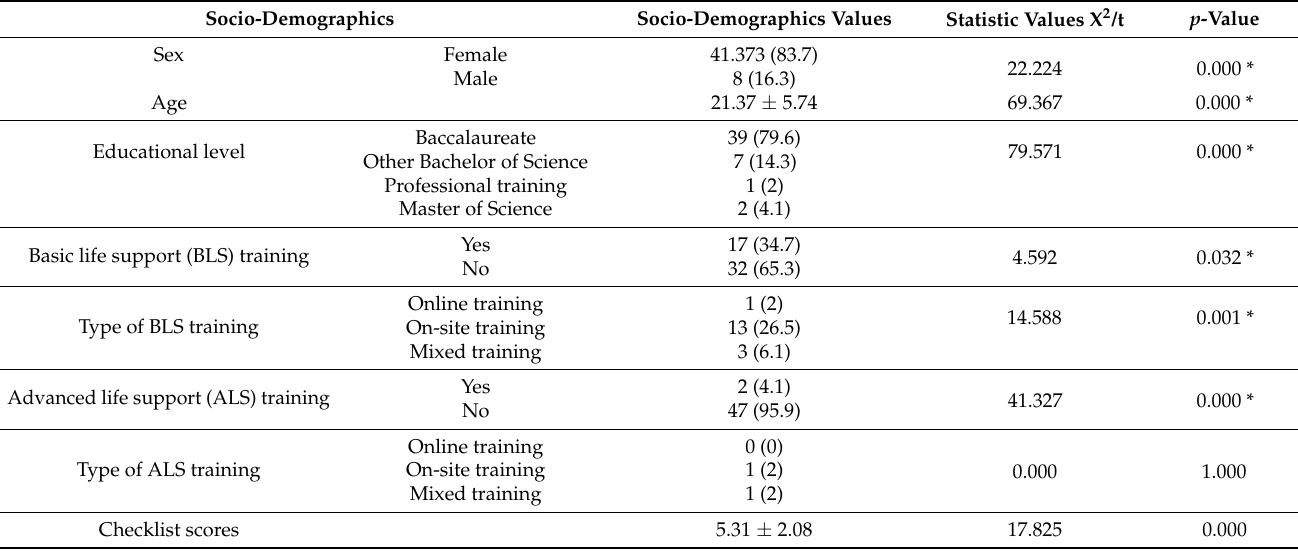
Table 1. Socio-demographic characteristics and checklist scores of